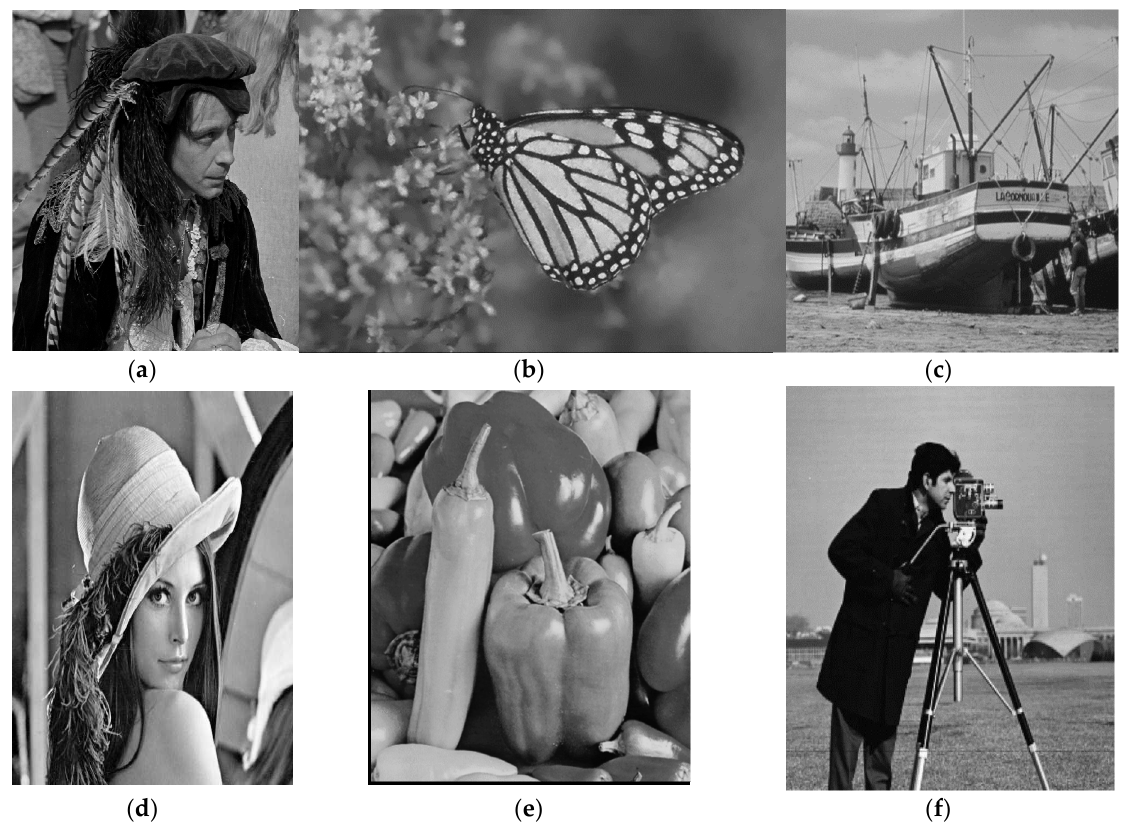
Figure 7. ( a ) Man (512 × 512); ( b ) Monarch (748 × 512); ( c ) Boat (512 × 512); ( d ) Lena (512 × 512); (e) Peppers (512 × 512); ( f ) Cameraman (512 × 512);.